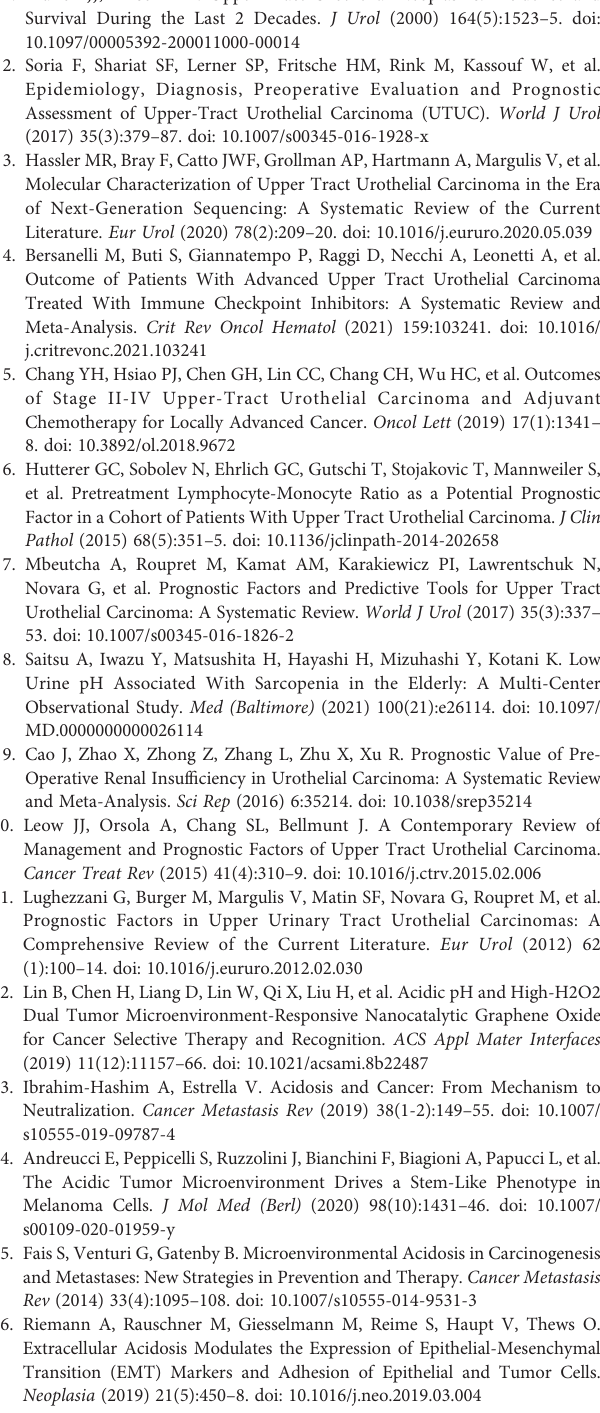
Supplementary Figure 2 | Kaplan-Meier curve of the effect of open surgical approach (blue) and minimally invasive surgical approach (dotted red) on disease- free survival and overall